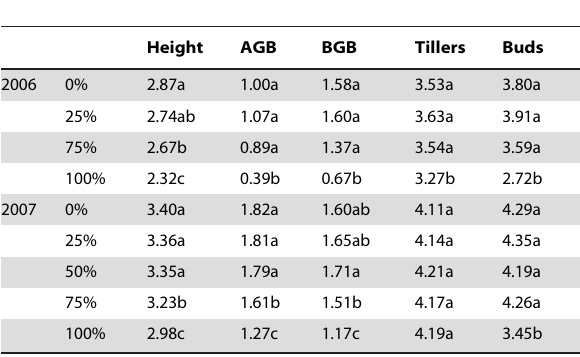
Table 1. Results of Duncan multiple comparisons of differences in height, aboveground biomass (AGB), belowground biomass (BGB), tillers and buds (back- transformed from the log scale) among clipping levels both in 2006 and